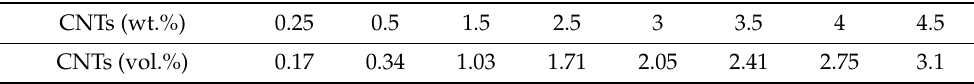
Table 1. Concentration of CNTs in PC matrix (wt.% and